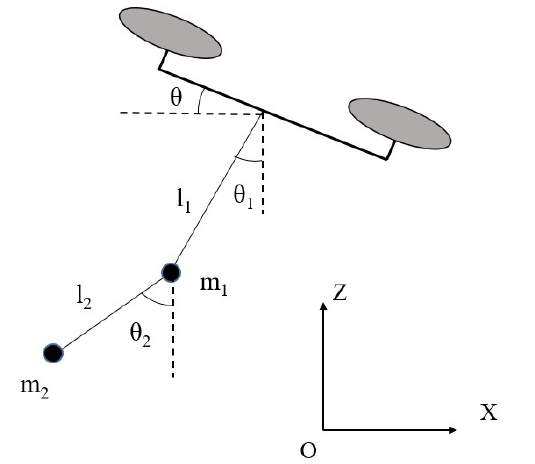
Figure 1. Schematic representation of the drone and double pendulum system in the considered (XZ) coordinate system for double pendulum